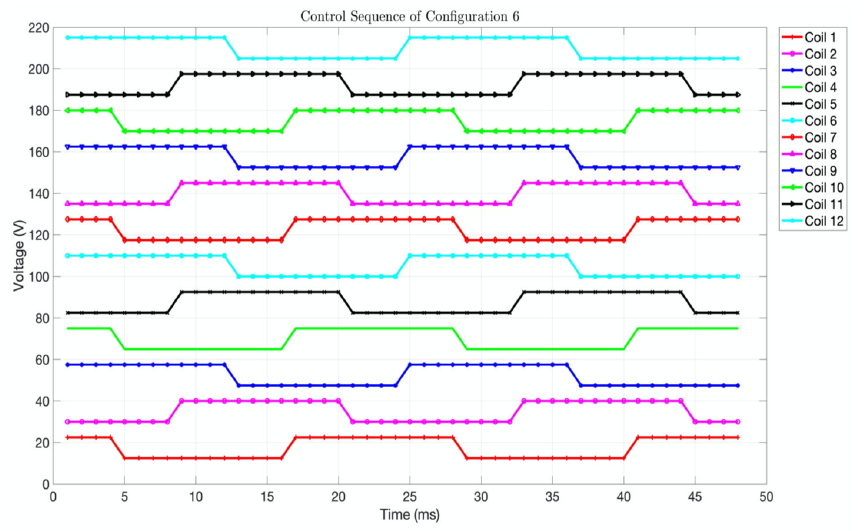
Figure 8. Switching signals of the twelve magnetic poles for CT6.